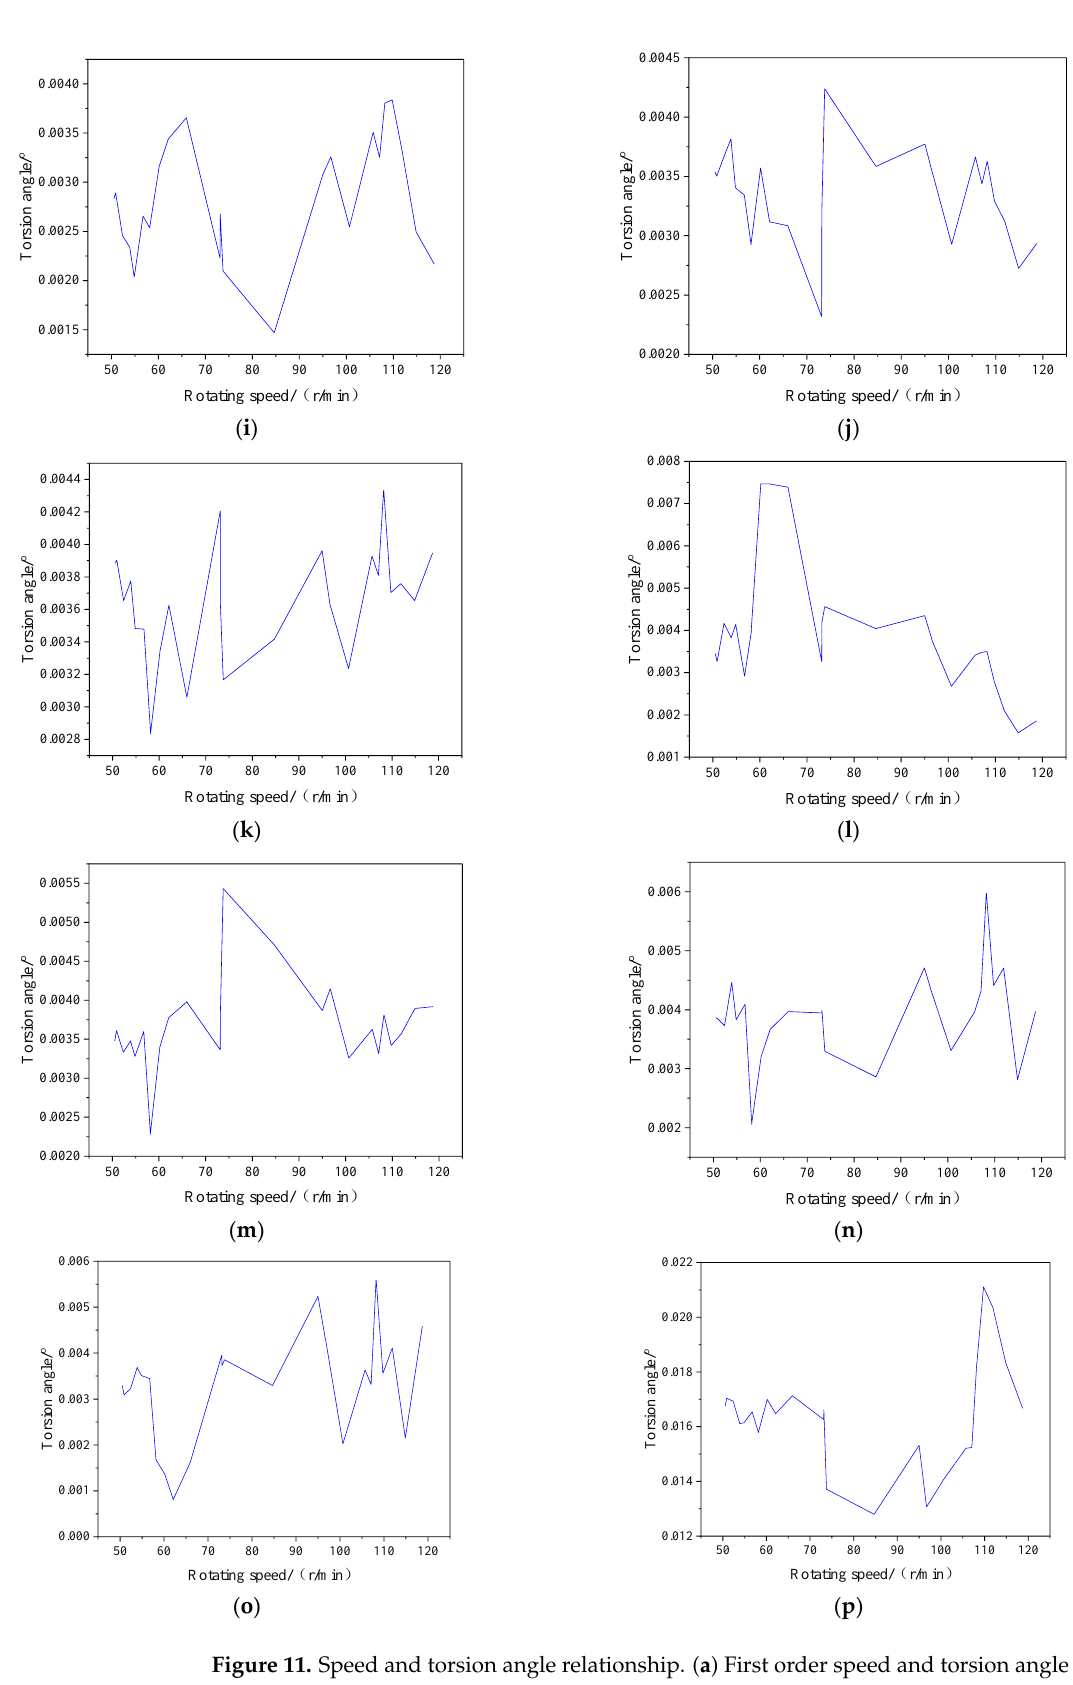
Figure 11. Speed and torsion angle relationship. ( a ) First order speed and torsion angle relationship. ( b ) Second order speed and torsion angle relationship. ( c ) Third order speed and torsion angle relationship. ( d ) Fourth order speed and torsion angle relationship. ( e ) Fifth order speed and